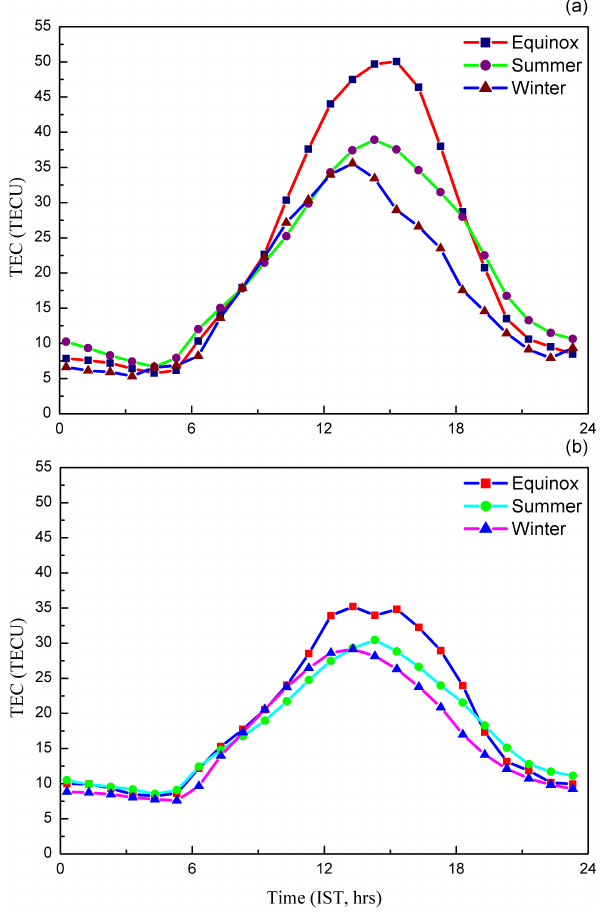
Fig. 3. Seasonal mean Diurnal variation of TEC during (a) 2005– 2006 and (b) 2006–2007 at Rajkot.